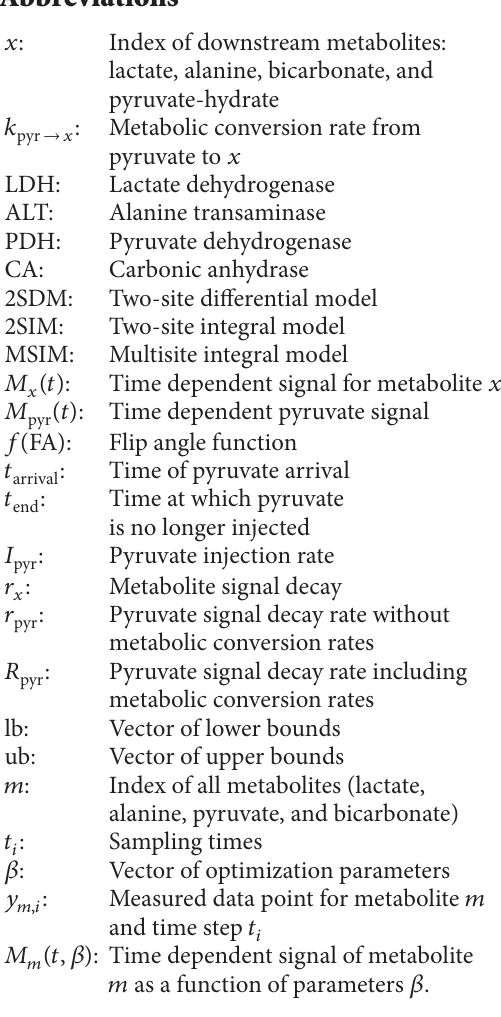
and 𝑘 conversion rates pyr → lac pyr → ala